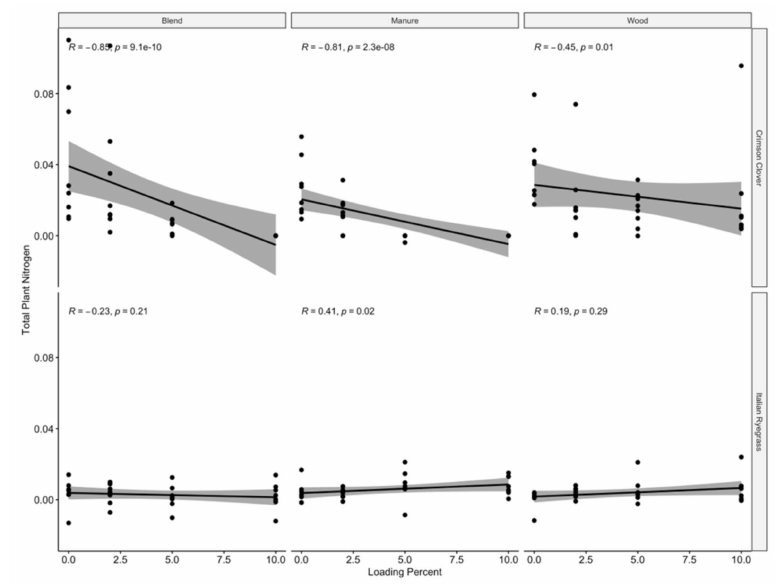
Figure 9. Total Plant N (g) × Loading Percent, Spearman’s correlation for T. incarnatum and L. multiflorum by BC